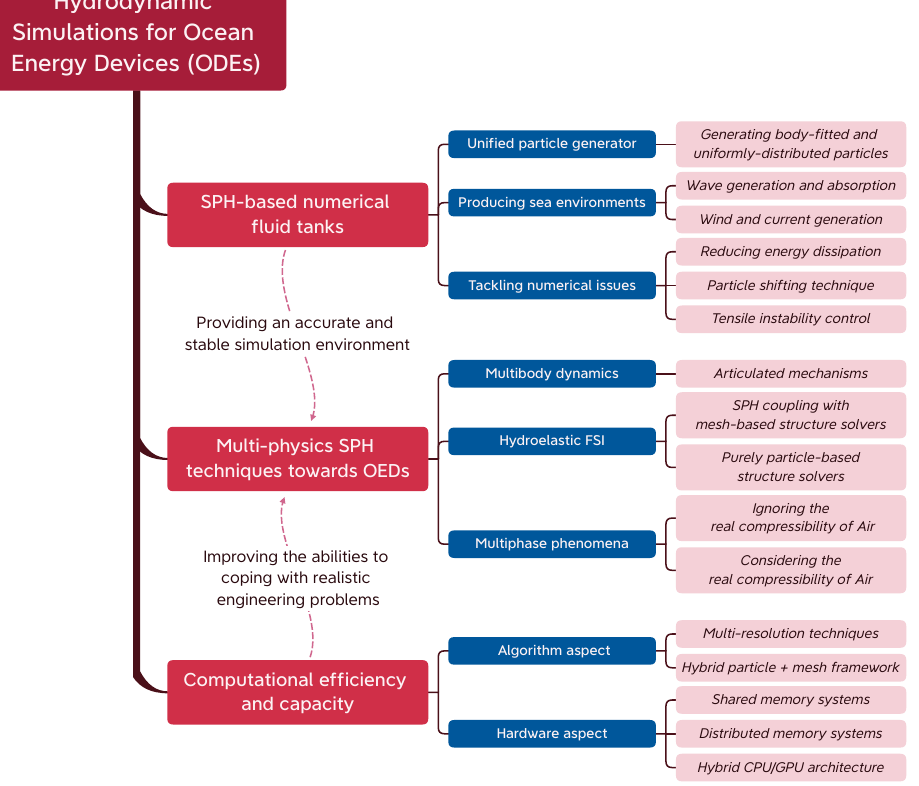
Figure 4. The outline of the present